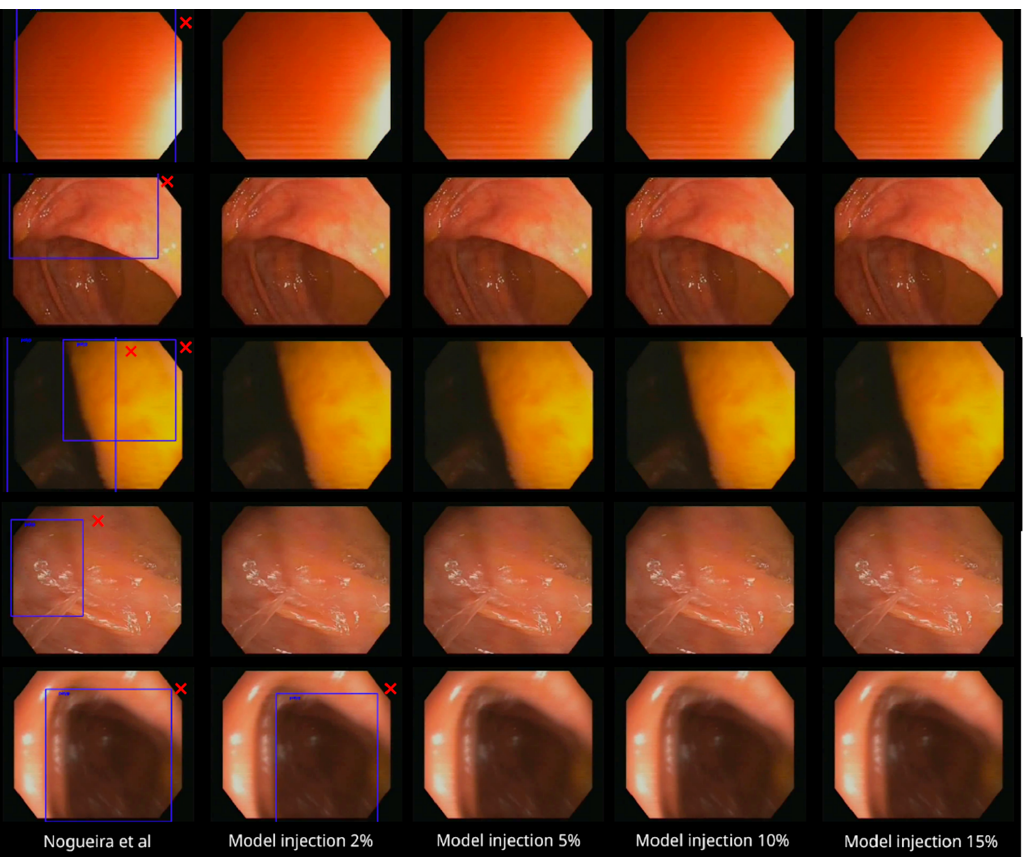
Figure 9 . The five models facing different situations found in two exploration videos included in PIBAdb (provided as Supplementary Videos S3 and S4), including close to the wall of the colon (first row), water jet (fourth row), or blurry images due to water jet (fifth row). False positives are marked as red cross marks [11].